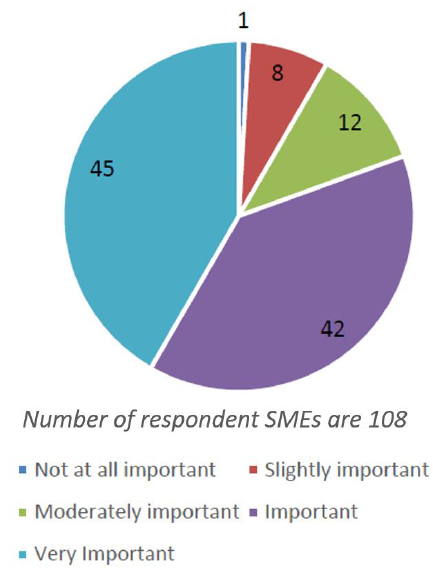
Figure 4. How important is optimising production facilities for your company?